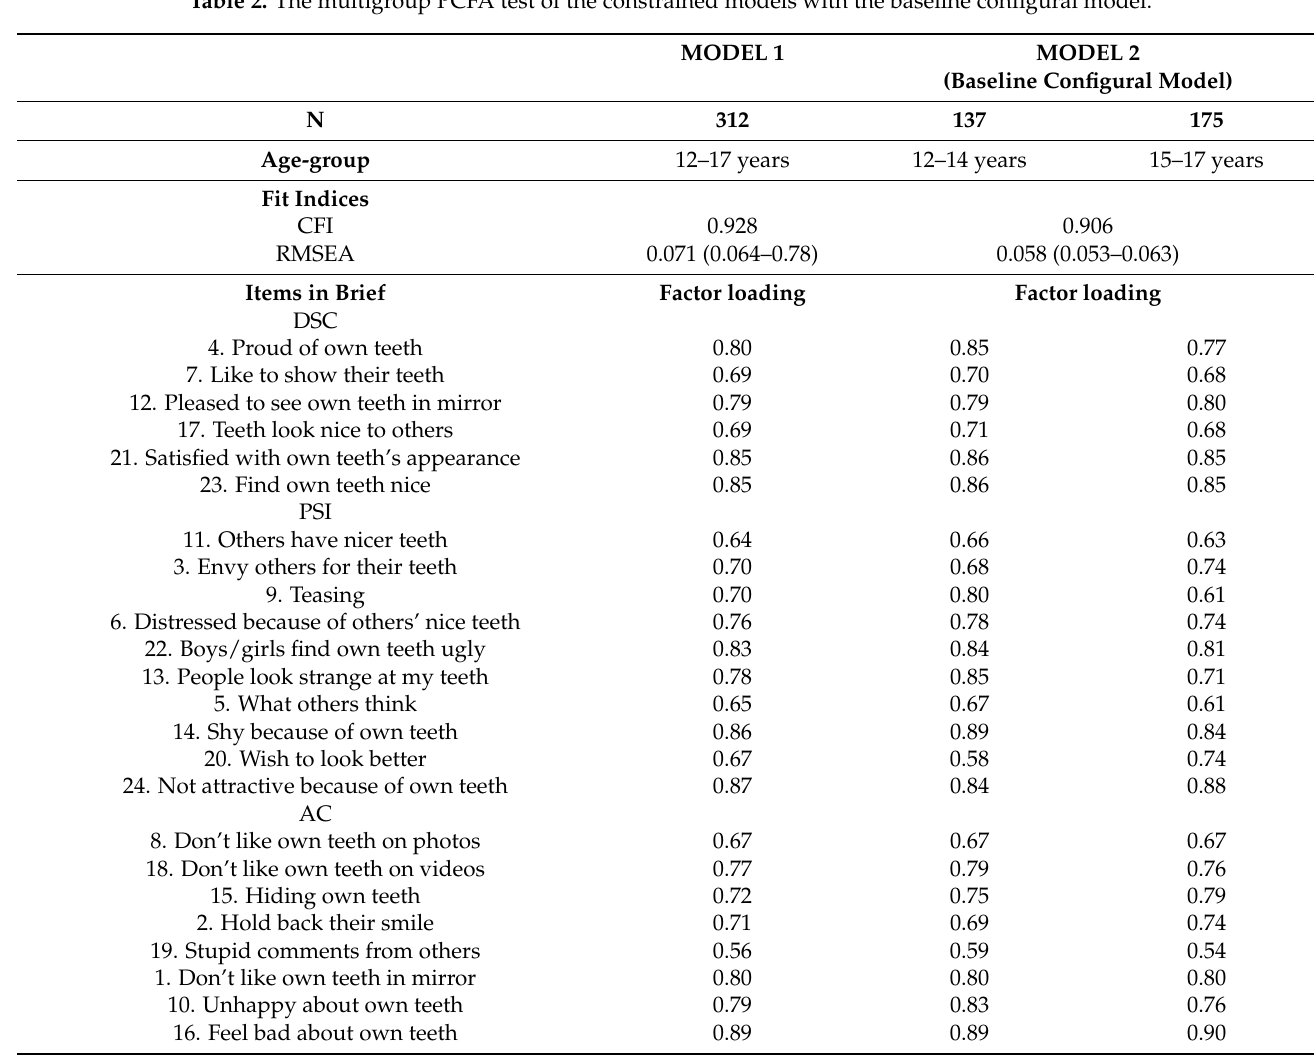
Table 2. The multigroup PCFA test of the constrained models with the baseline configural